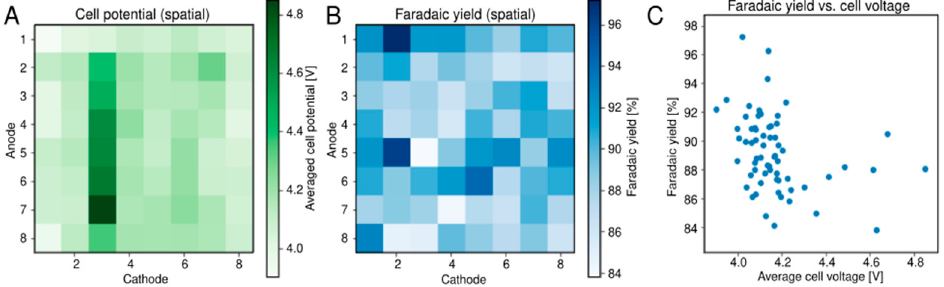
Figure 6. Spatial distribution of cell voltages ( A ) and Faradaic yield ( B ) for the alcohol oxidation reaction at Ni(O)OH. ( C ) The same data, with cell voltage plotted against Faradaic yield.